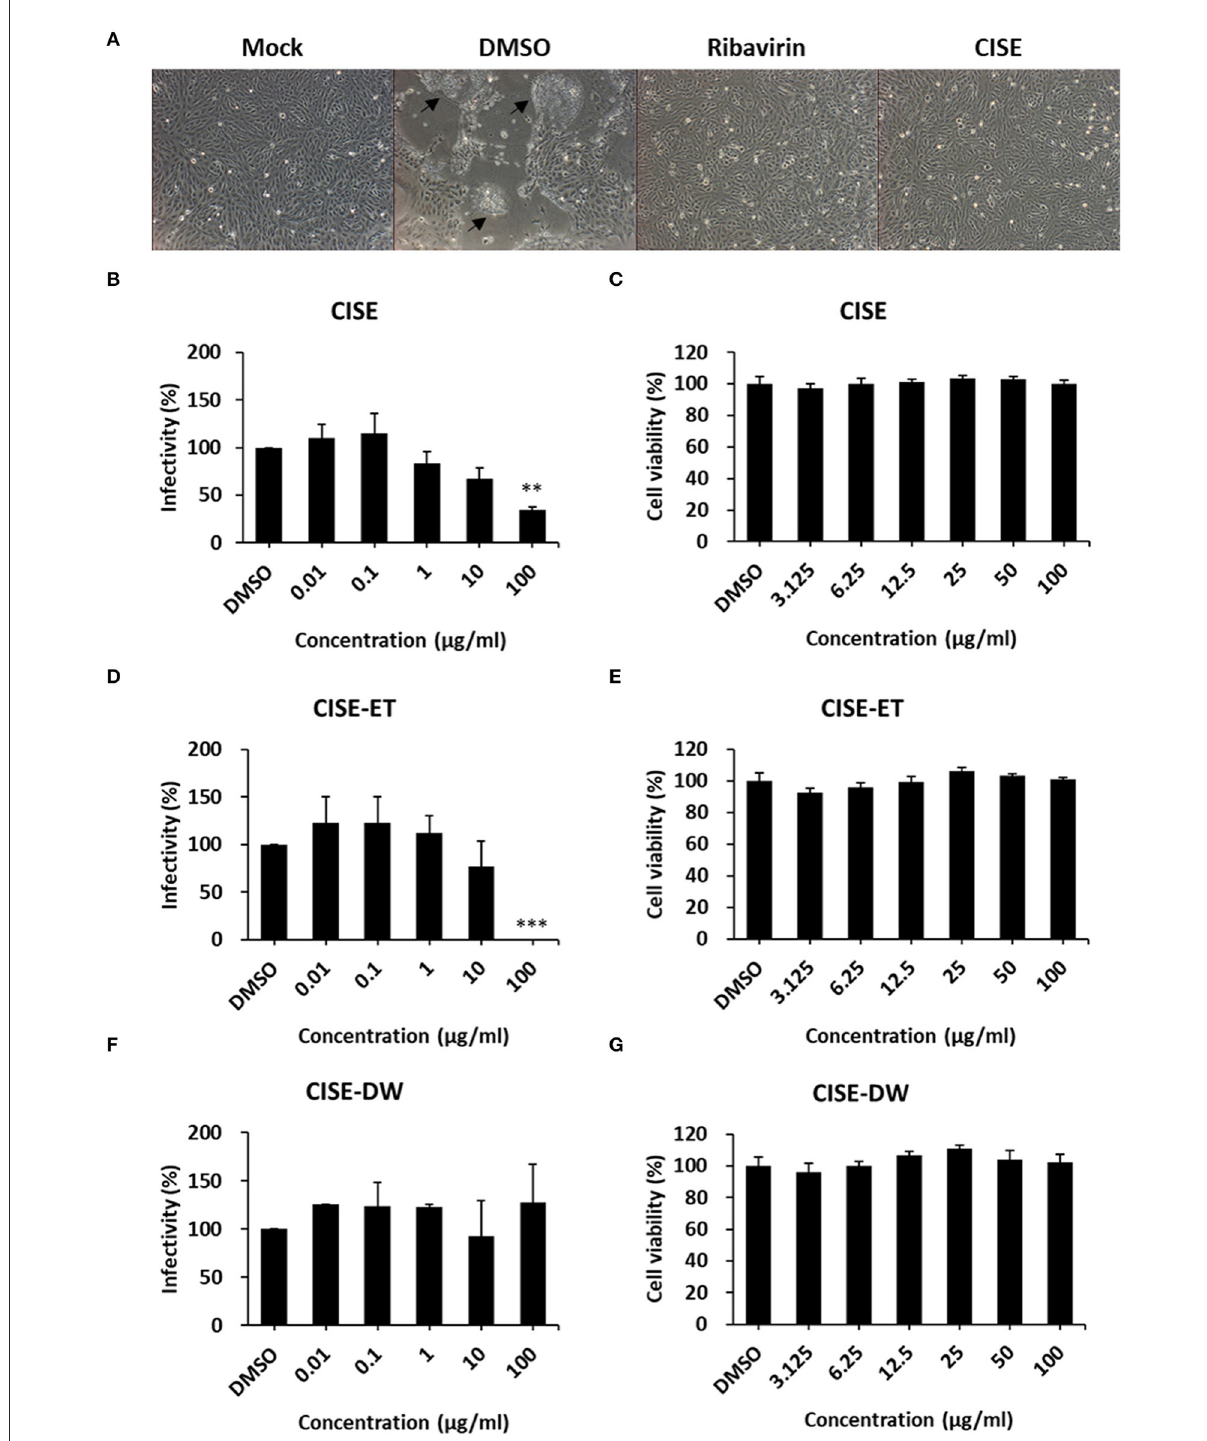
FIGURE2 CISE inhibited PEDV infection in Vero cells. (A) Vero cells were infected with PEDV (MOI = 0.1) in the presence of CISE (50 µ g/ml), ribavirin (50 µ g/ml), or a DMSO control. At 24 hpi, a cytopathic effect (black arrow) was observed. (B–G) Vero cells were infected with PEDV (MOI = 0.1) in the presence of various concentrations of CISE (B) , CISE-ET (D) , or CISE-DW (F) . At 24 hpi, the virus titers were measured by plaque assay. Vero cells were incubated with various concentrations of CISE (C) , CISE-ET (E) , or CISE-DW (G) for 24h, and the cell viability was then evaluated by the MTT assay. The antiviral activity and cell viability are expressed relative to those found for the DMSO control group. The error bars represent the SDs from the means ( n = 3). ** P < 0.01; *** P <